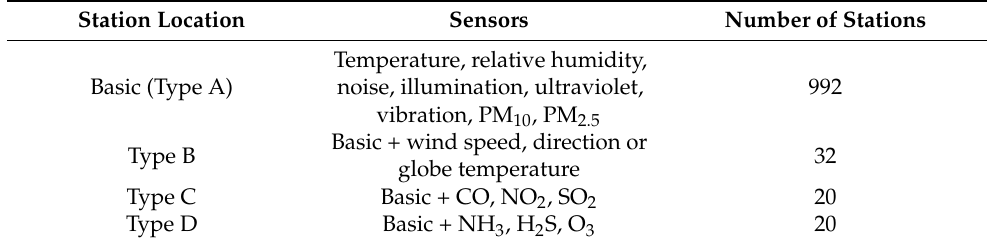
Table 2. Installed sensors with respect to the S-DoT station types. Station Location Sensors Number of Stations Temperature, relative humidity, Basic (Type A) noise, illumination, ultraviolet, vibration, PM 10 , PM 2.5 globe